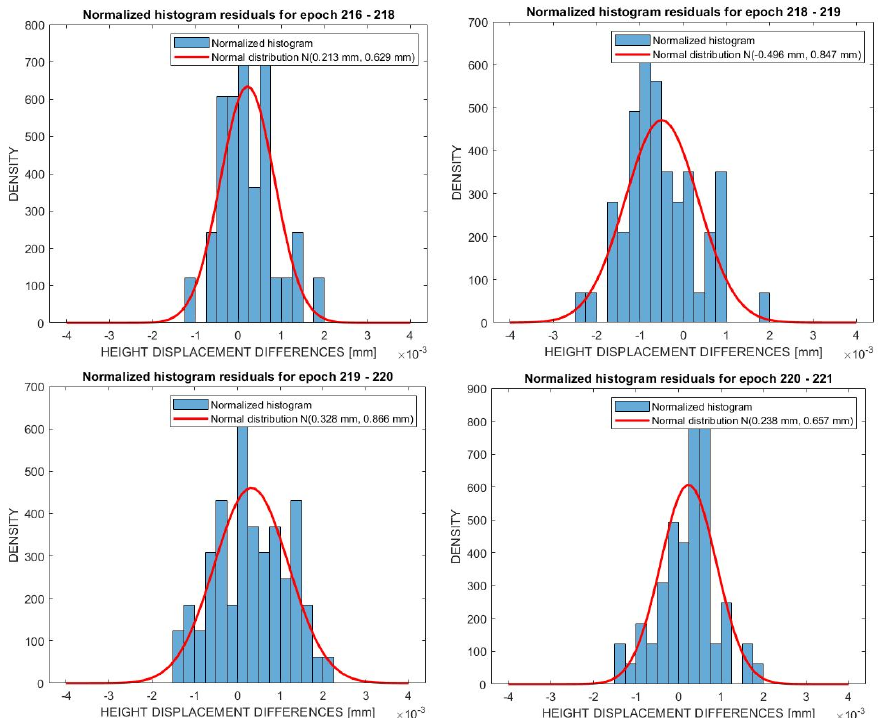
Figure 16. Normalized histograms and distribution of residuals for epochs for BEAM 2. (Source: Own compilation).